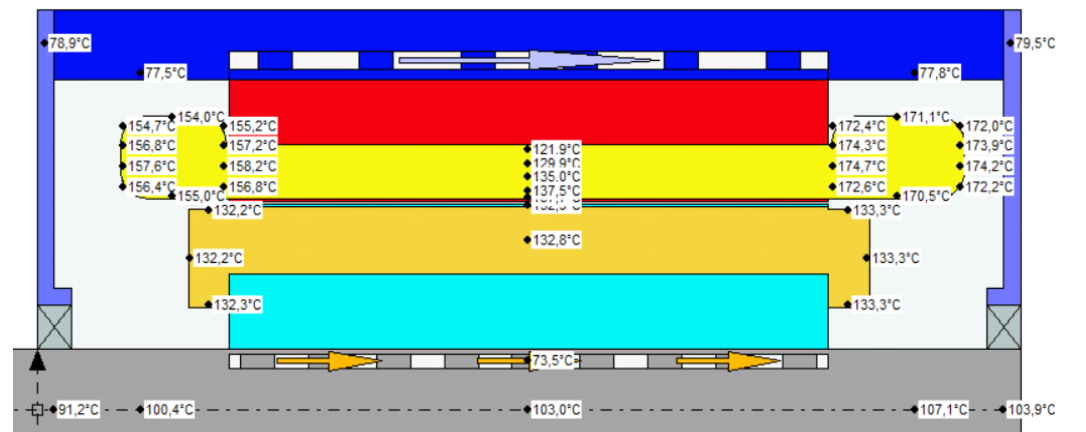
Figure 4. Steady-state temperature at rated power and ambient temperature of 50 °C for the same cooling system: ( a ) design D1; ( b ) design D2; ( c ) design D3. cooling system: ( a ) design D1; ( b ) design D2; ( c ) design